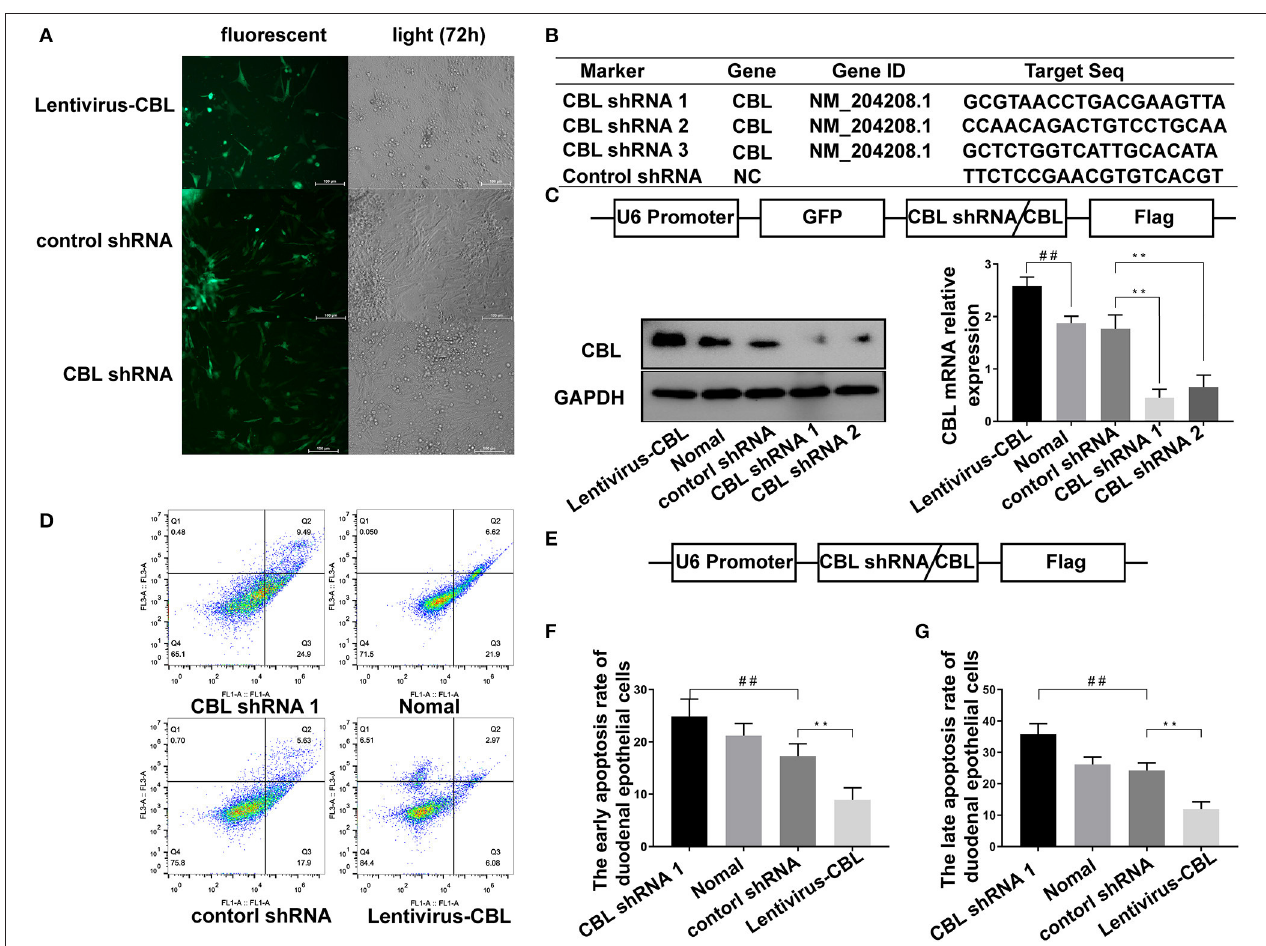
FIGURE 4 | The effect of shRNA targeting CBL protein on chick duodenal epithelial cell apoptosis. (A) CBL shRNA and green fluorescent protein were successfully expressed in duodenal epithelial cells. (B) Three shRNAs targeting the CBL mRNA and one blank shRNA were designed and synthesized. (C) The construction strategy for the CBL shRNA and overexpression vector is displayed. Western blot and RT-PCR results show CBL protein expression in the CBL shRNA, normal and lentivirus-CBL groups at 72h after infection. (D) Flow cytometry shows the apoptosis rate of chick duodenal epithelial cells in the control, CBL shRNA, lentivirus-CBL, and normal groups. (E) The construction strategy for the lentivirus vectors carrying CBL shRNA/CBL without green fluorescent protein. “ ## ” represents the apoptotic rate of host cells in control shRNA group was significantly lower than that in the CBL shRNA group ( + P < 0.01). (F) Quantitative analysis of the early apoptosis rate of chick duodenal epithelial cells in the control, CBL shRNA, lentivirus-CBL, and normal groups. (G) Quantitative analysis of the late apoptosis rate of chick duodenal epithelial cells in control, CBL shRNA, lentivirus-CBL, and normal groups. “ ** ” represents the apoptotic rate of host cells in Lentivirus-CBL group was significantly lower than that in the control shRNA group ( + P <